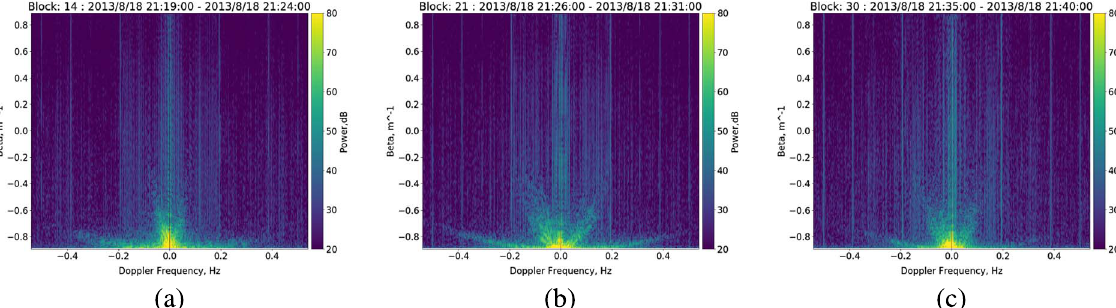
Fig. 3. Example delay-Doppler spectra from the fi rst hour of observation, taken using 5-min chunks of the dynamic spectrum from CS103 over the frequency band 28.5 – 64.1